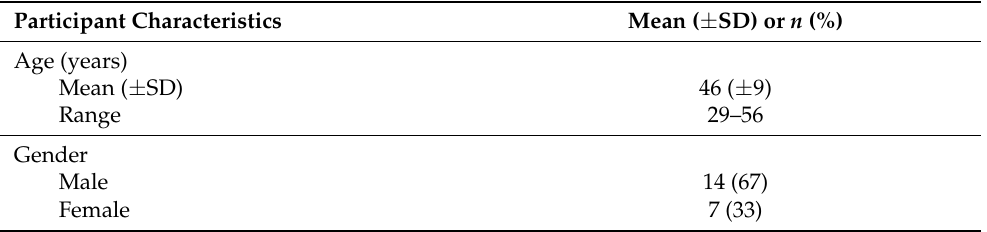
Table 1. Interviewee